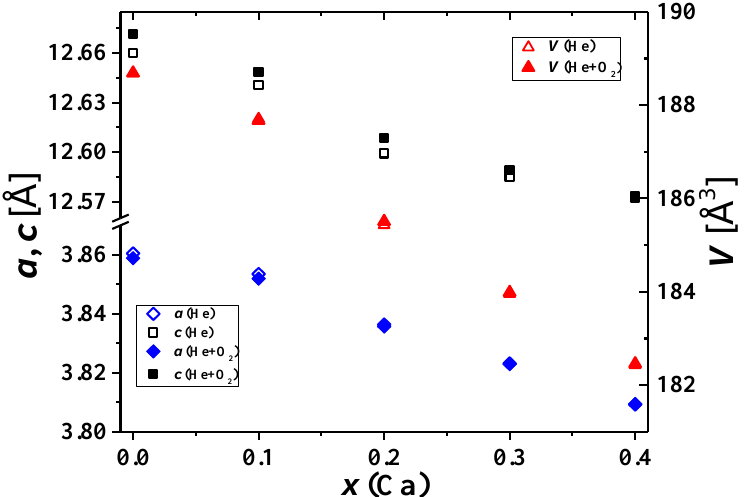
Figure 5. Concentration dependences of the unit cell parameters and volumes for the La 2−x Ca x NiO 4+δ samples after sequential treatment under atmospheres with high and low pO 2. XRD data obtained at the anomalous scattering station (SSRTC, Novosibirsk) at a wavelength of 0.15402 nm. Temperature dependences of the unit cell parameters and the volume obtained in the He+O 2 gas mixture (at p O 2 equal to 0.2) for the LNO and LCNO01-04 samples pretreated